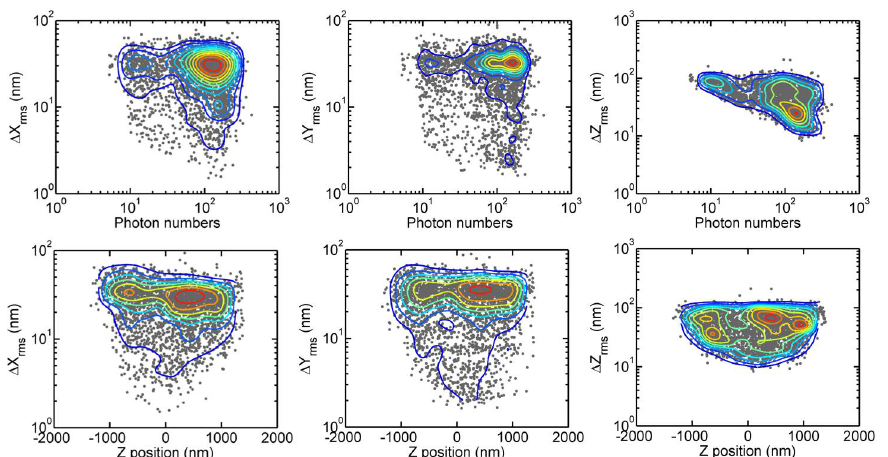
Figure 2. Distribution of localized coordinates of Alexa-488 doped polystyrene beads with a diameter of 100 nm embedded in an agarose gel matrix. ( top row ) Localization errors as a function of fluorescent photon number; ( bottom row ) localization errors as a function of z -coordinates of fluorescent beads relative to imaging focal plane ( z =